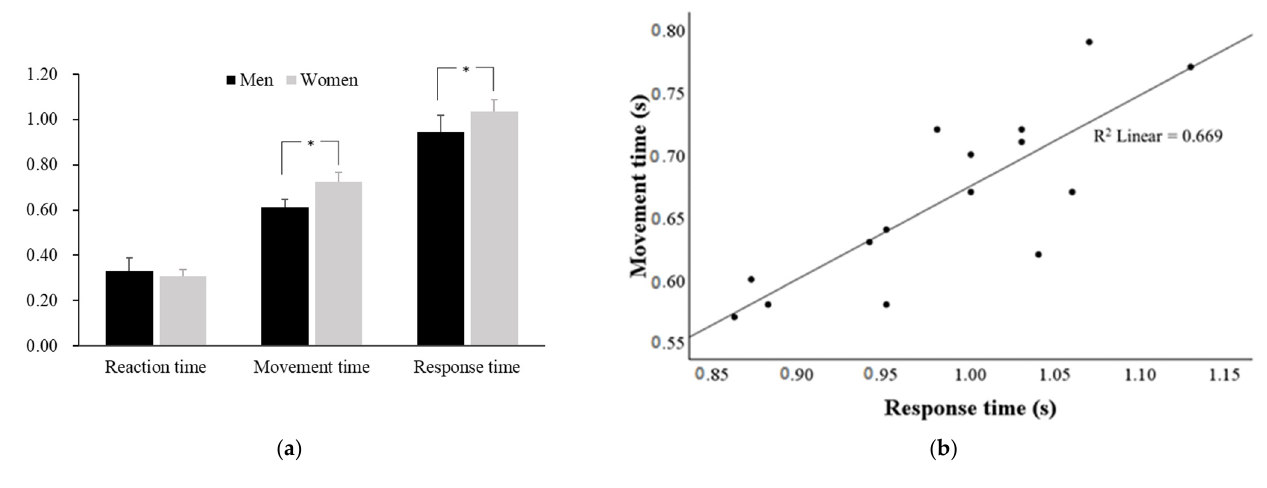
Figure 2. The reaction time, movement time, and response time between male and female athletes ( a ); correlation with the movement time and the response time in fencing athletes including male and female ( b ). * p < 0.05.